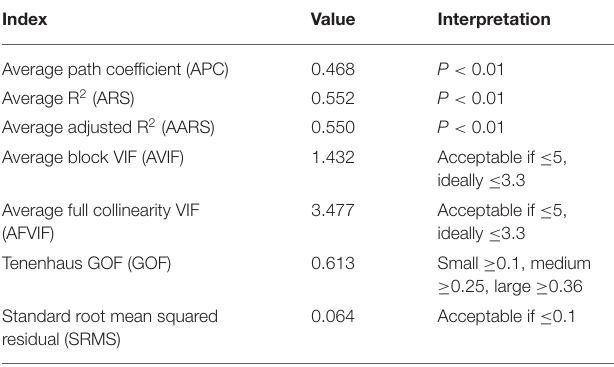
TABLE 4 | Model fit indices.